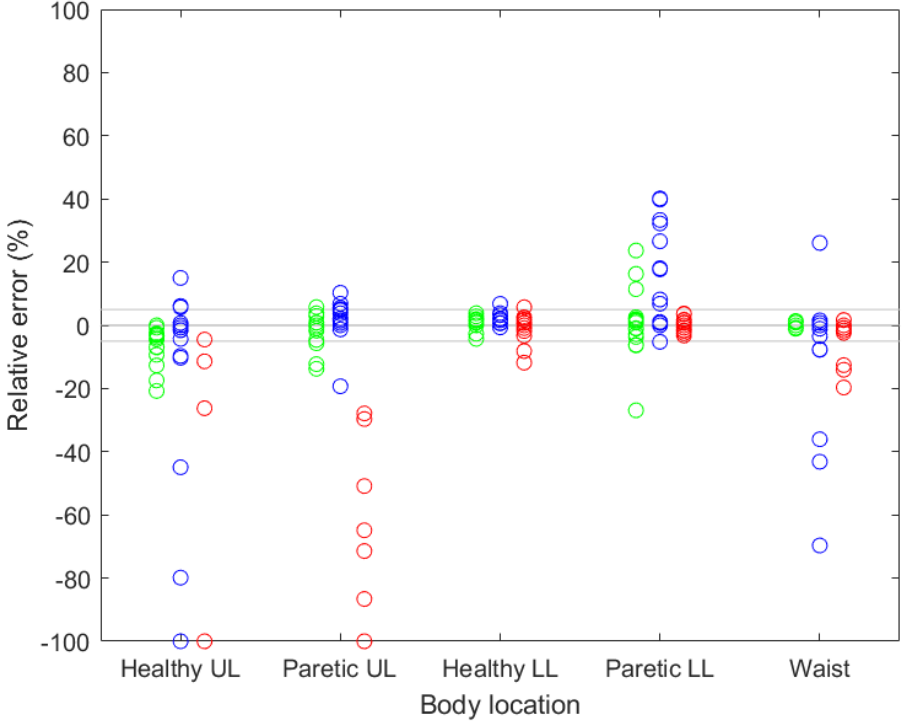
Figure 3. Relative deviations of all the activity trackers when walking without any aid (green), with a single-point stick (blue) and with a rolling walker (red). UL—upper limb, LL—lower limb. Boxplots on Figures 4–6 show relative deviations specifically for each of the three cases, i.e., (1) walking without any walking aid (Figure 4), (2) walking with a single-point stick (Figure 5) and (3) walking with a rolling walker (Figure